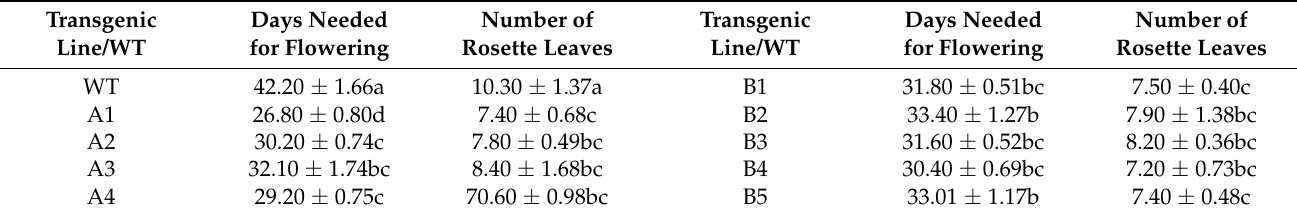
Table 2. Days needed for flowering and number of rosette leaves.